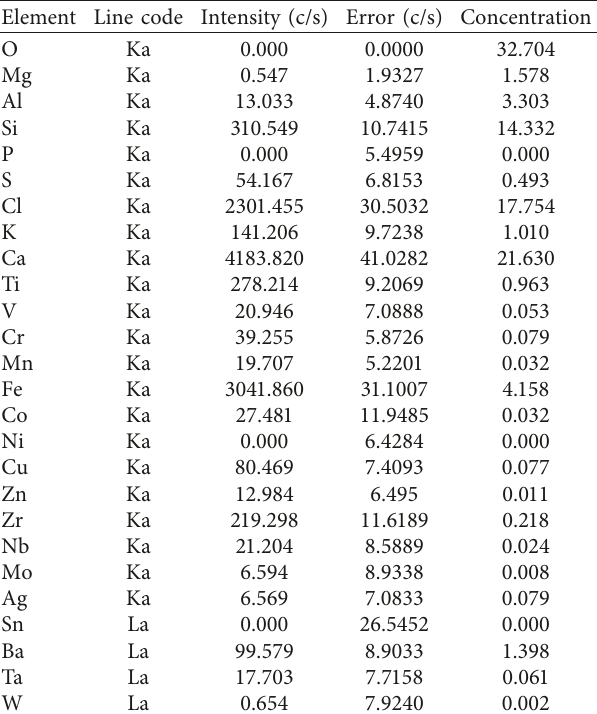
Table 5: XRF element result for contaminated soil characterization.